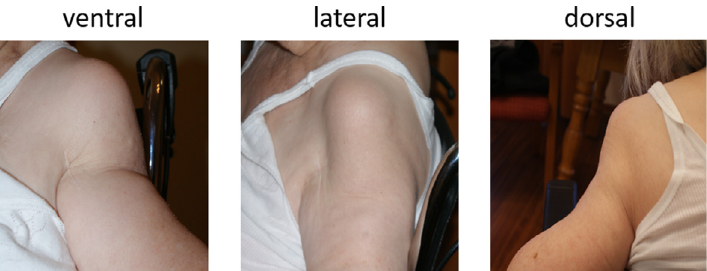
Figure 1. Left shoulder photographs of an 84-year-old female (patient 1) suffering Gorham-Stout syndrome in April 2011: the original contour of the shoulder vanished completely.